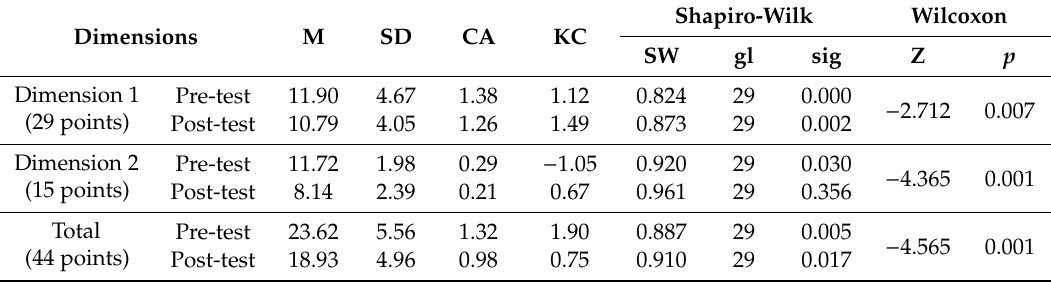
Table 5. Comparison between pre-test and post-test in the experimental